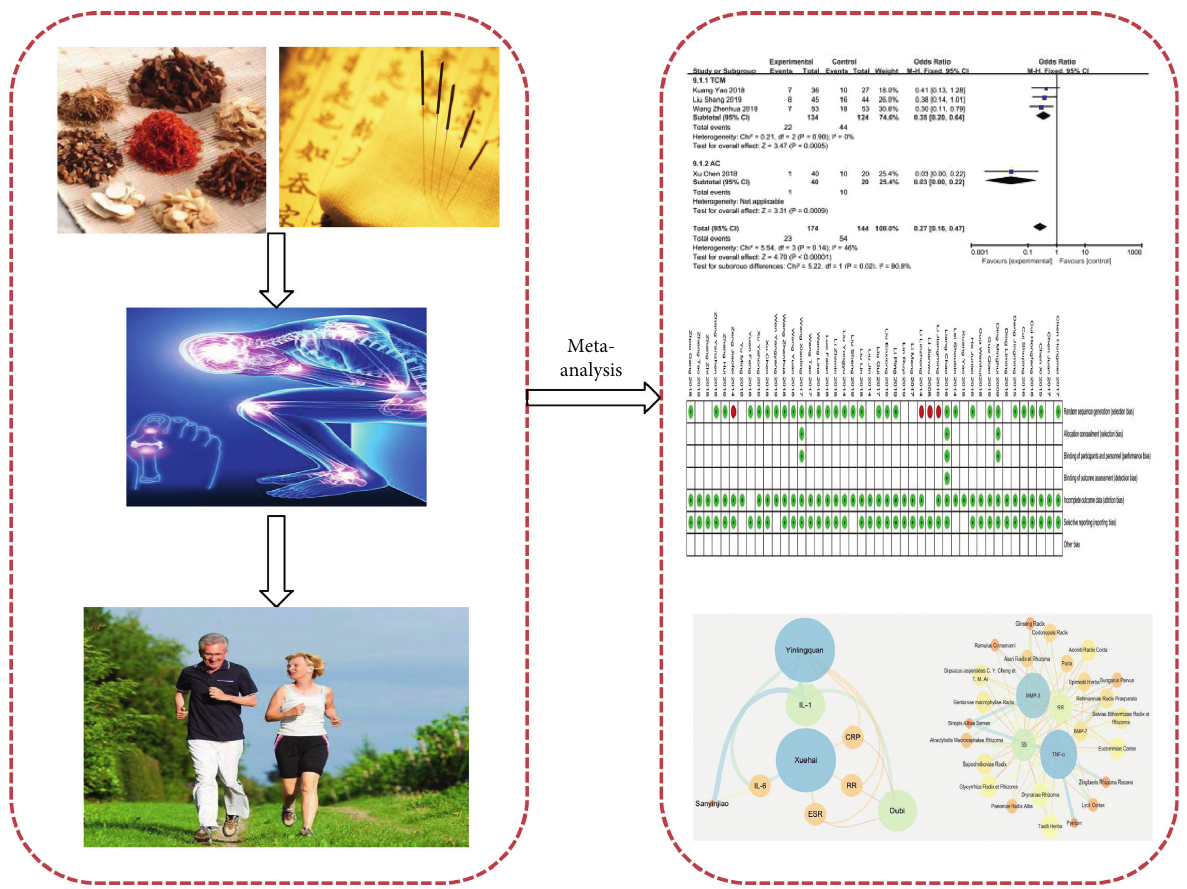
Figure 1: Work flow of the present